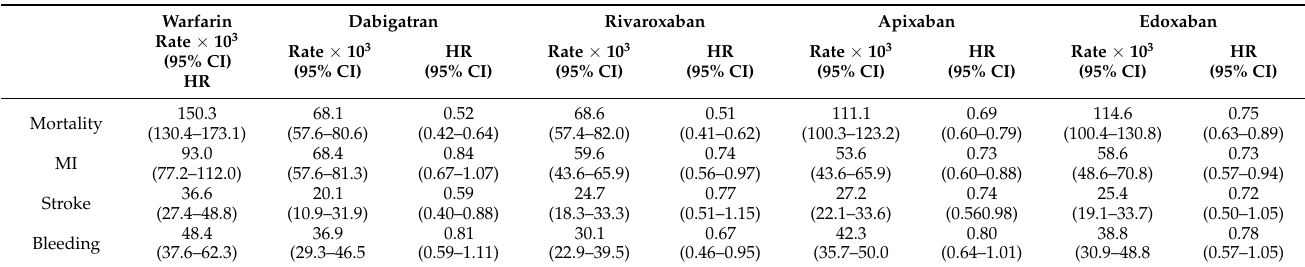
Table 3. Adjusted hazard ratios (HR ˆ) and 95% confidence intervals (95% CI) for overall mortality and hospitalization for myocardial infarction, stroke or bleeding for users of each analyzed anticoagulant agent vs. warfarin (reference). Warfarin Dabigatran Rivaroxaban Apixaban Edoxaban Rate × 10 3